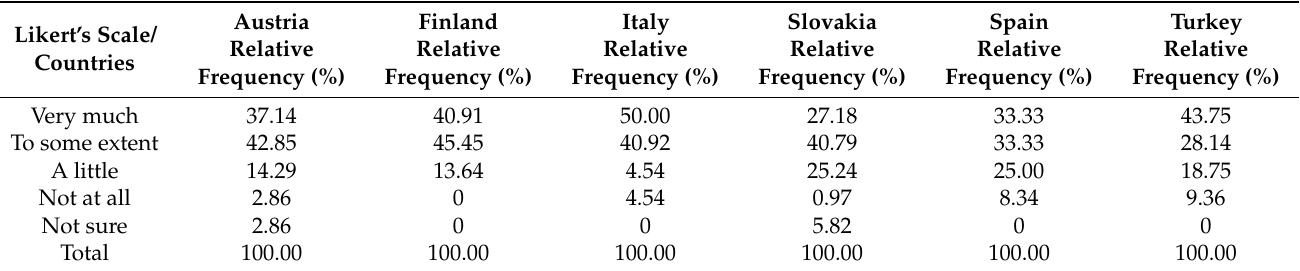
Table 5. The data comparison showing the extent to which the sustainability principle guides the work in the organisation, according to participating countries (own elaboration, 2021).